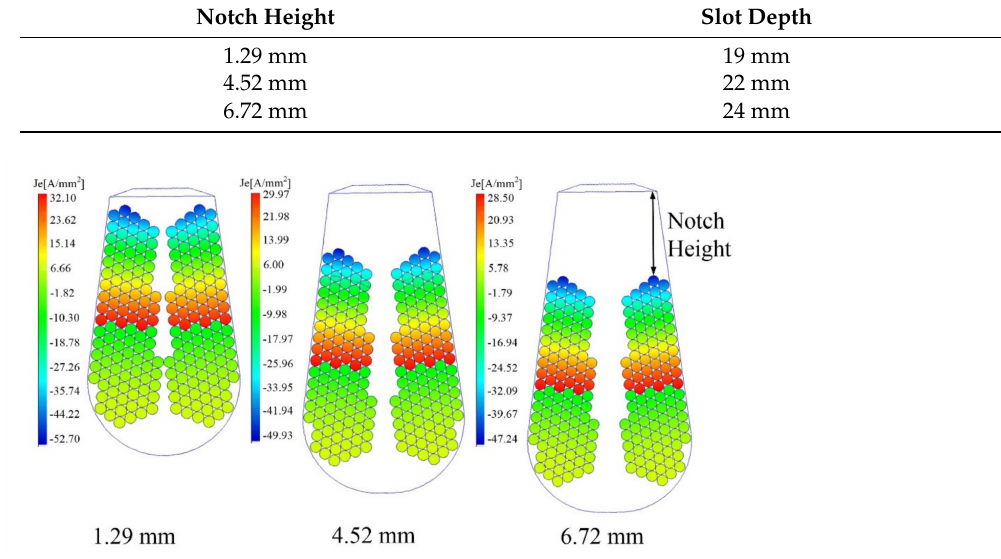
Figure 19. Current density with notch height at 1000 Hz.